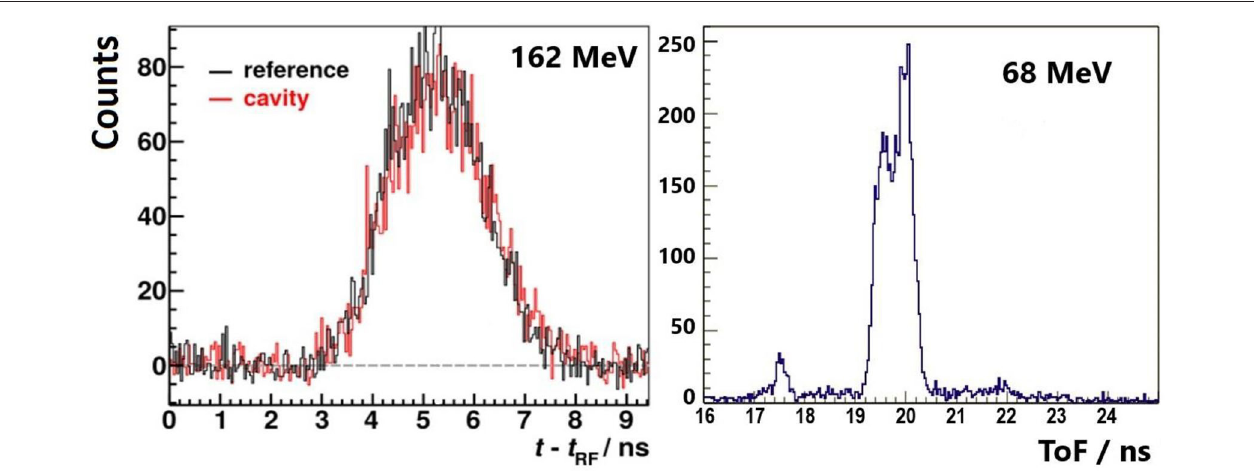
FIGURE 1 | Experimental prompt-gamma timing spectra obtained with proton beams in PMMA targets; (Left) at clinical intensity, with synchronization to the cyclotron RF signal (pulse by pulse basis for a single beam spot of 3.8 9cm depth); (Right) ion-per-ion basis at 68 MeV, using a diamond beam trigger at low intensity, a 2.5cm thick air insert is located at 1cm from the target entrance. The number of protons used to generate the second histogram is similar (